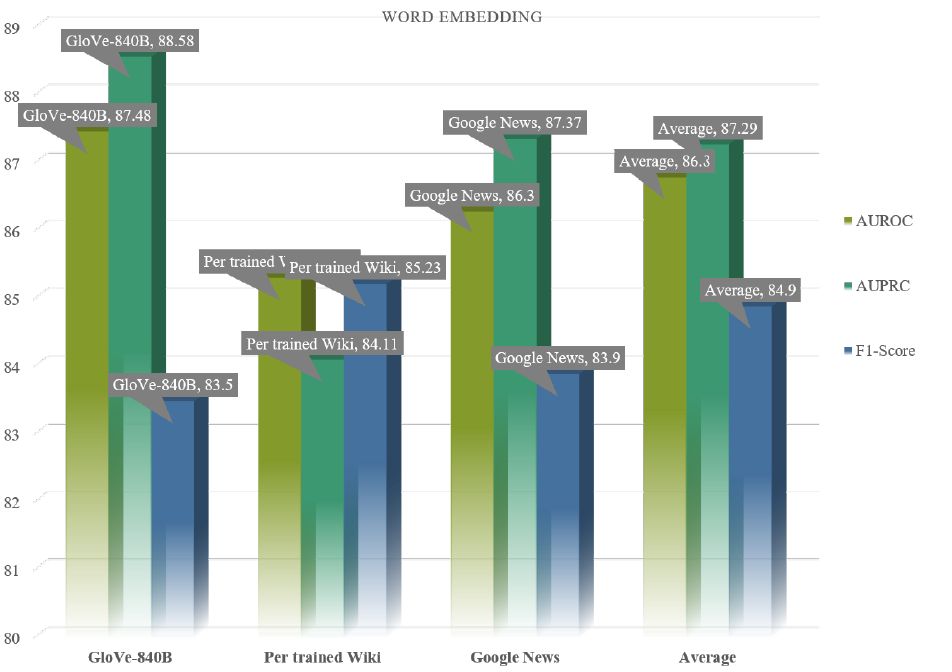
Figure 6. Analysis of different word